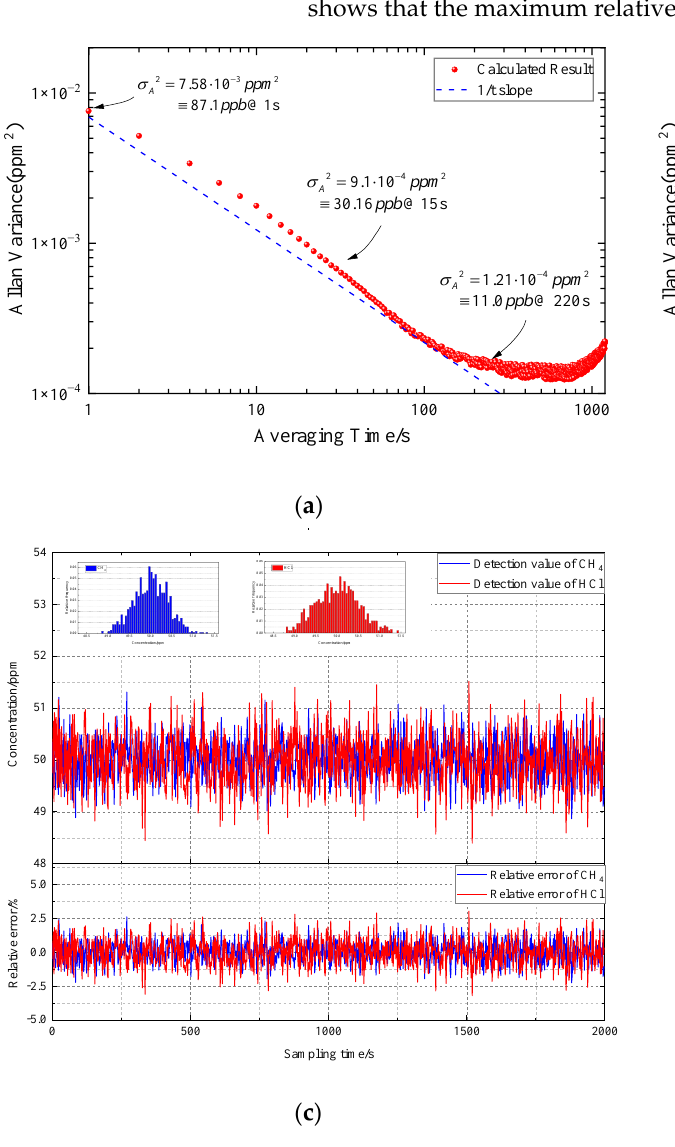
Figure 9. Performance evaluation of the FDM-WMS detection system: ( a ) Allan variance analysis of CH 4 .; ( b ) Allan variance analysis of HCl.; ( c ) measurement precision analysis of the FDM-WMS sys- tem.